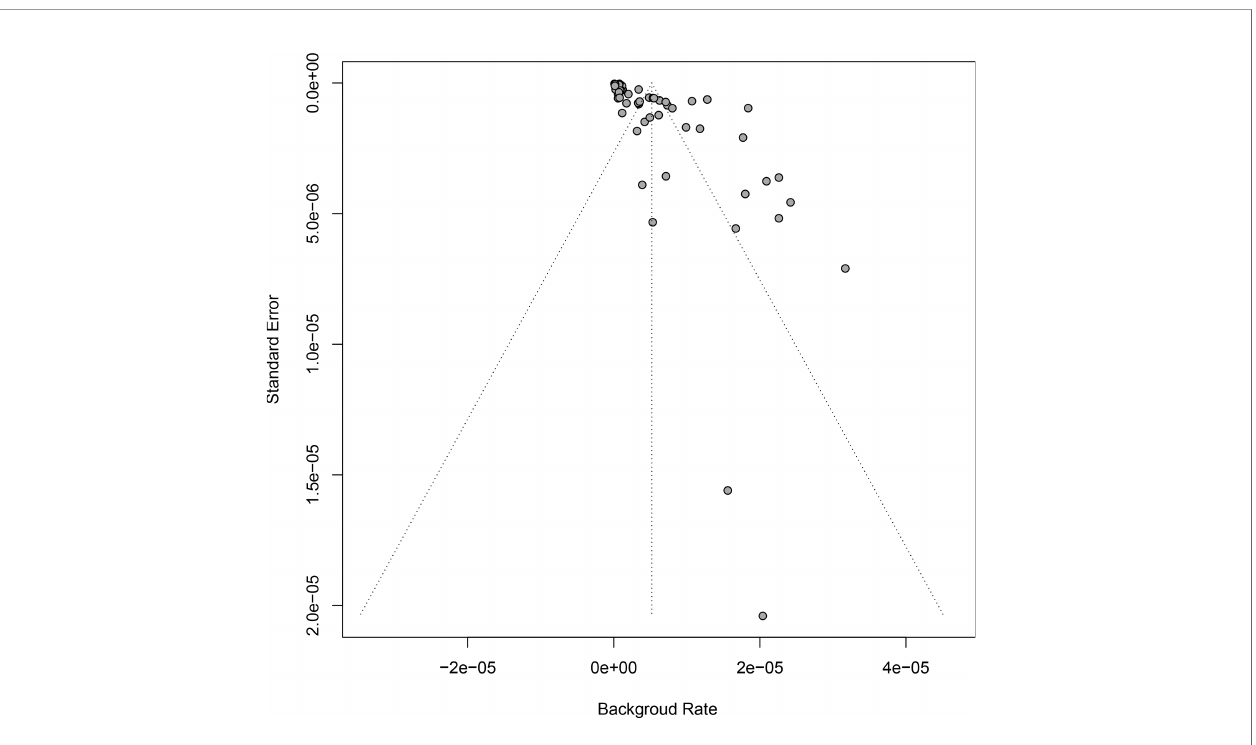
FIGURE 3 | Funnel plot for publication bias